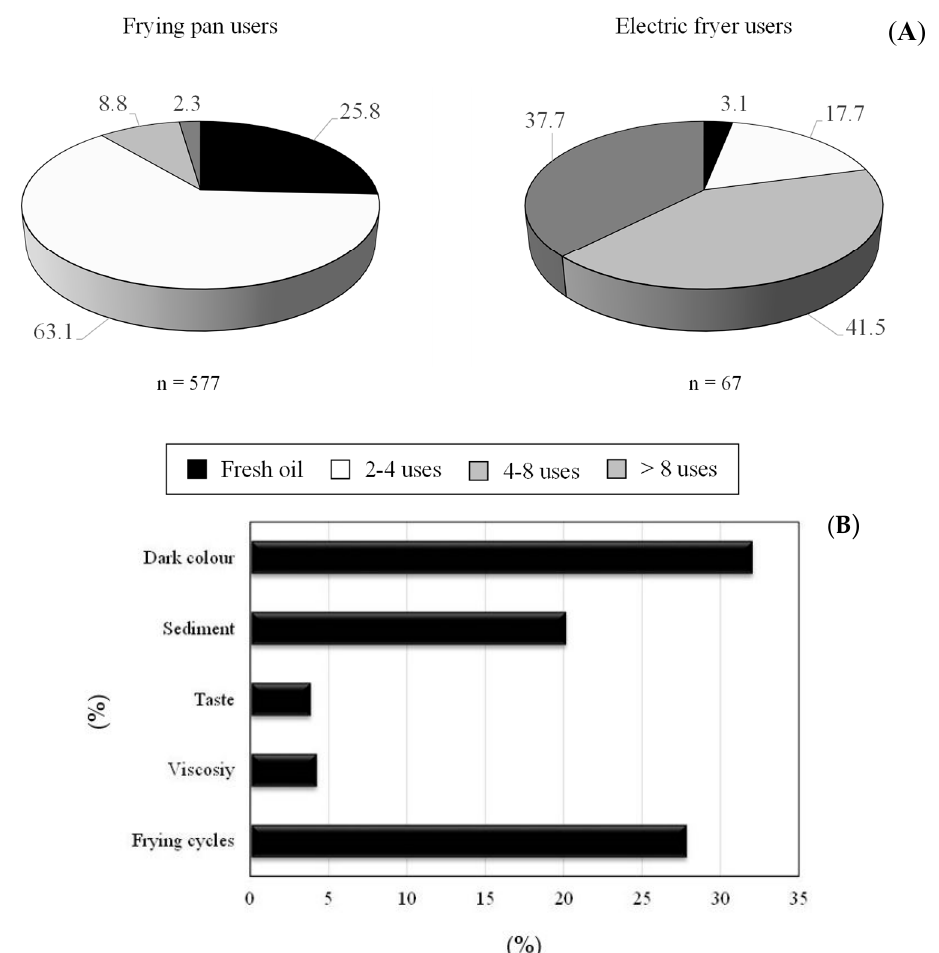
Figure 7. Frequency of use of frying oil ( A ) and reason for changing ( B ).